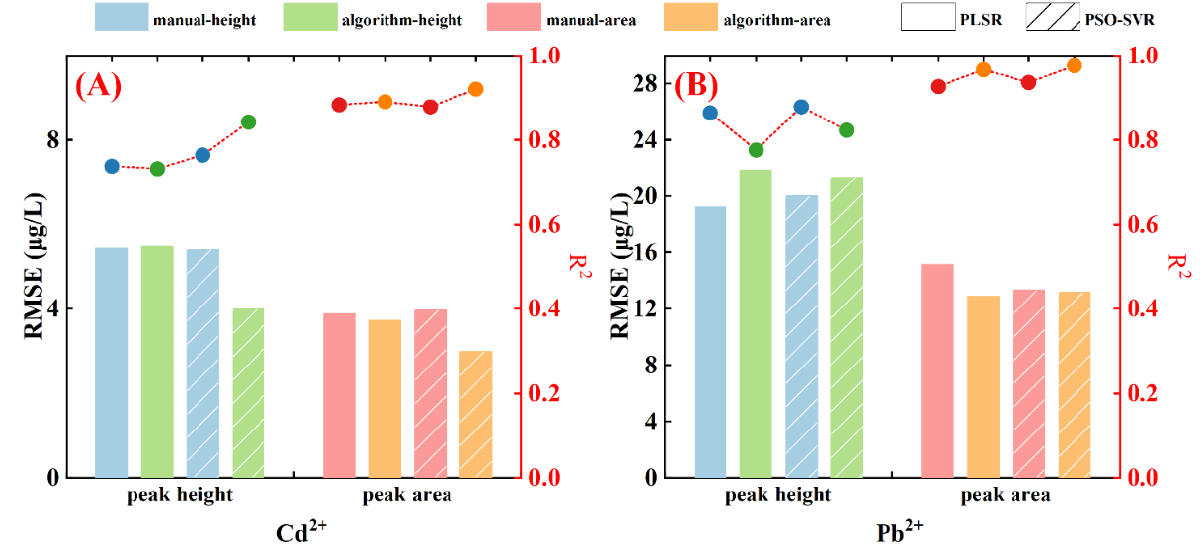
Figure 10. Model results of the validation sets for Cd 2+ ( A ) and Pb 2+ ( B ) concentration detection.